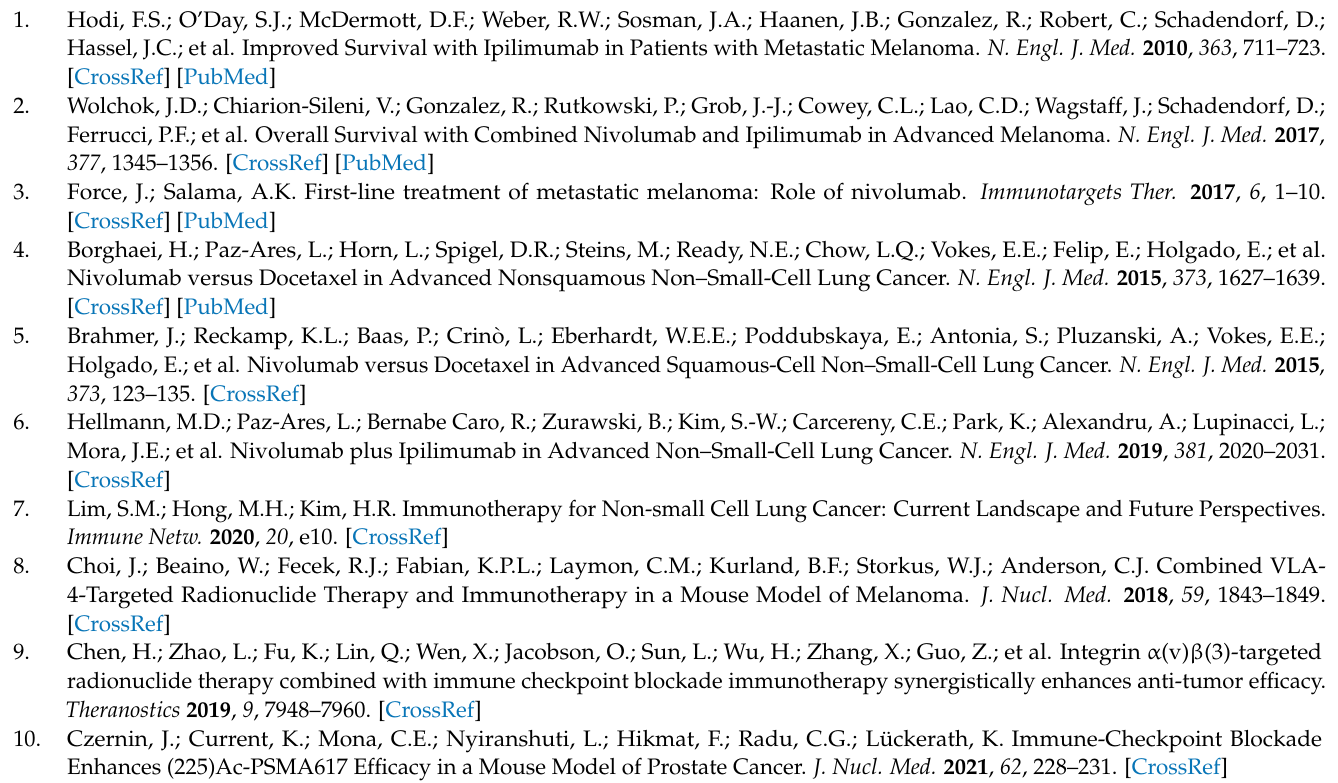
Figure S2: Representative flow gating graphs for the ( A ) dendritic lineage and ( B ) myeloid lineage cell populations analyzed in this